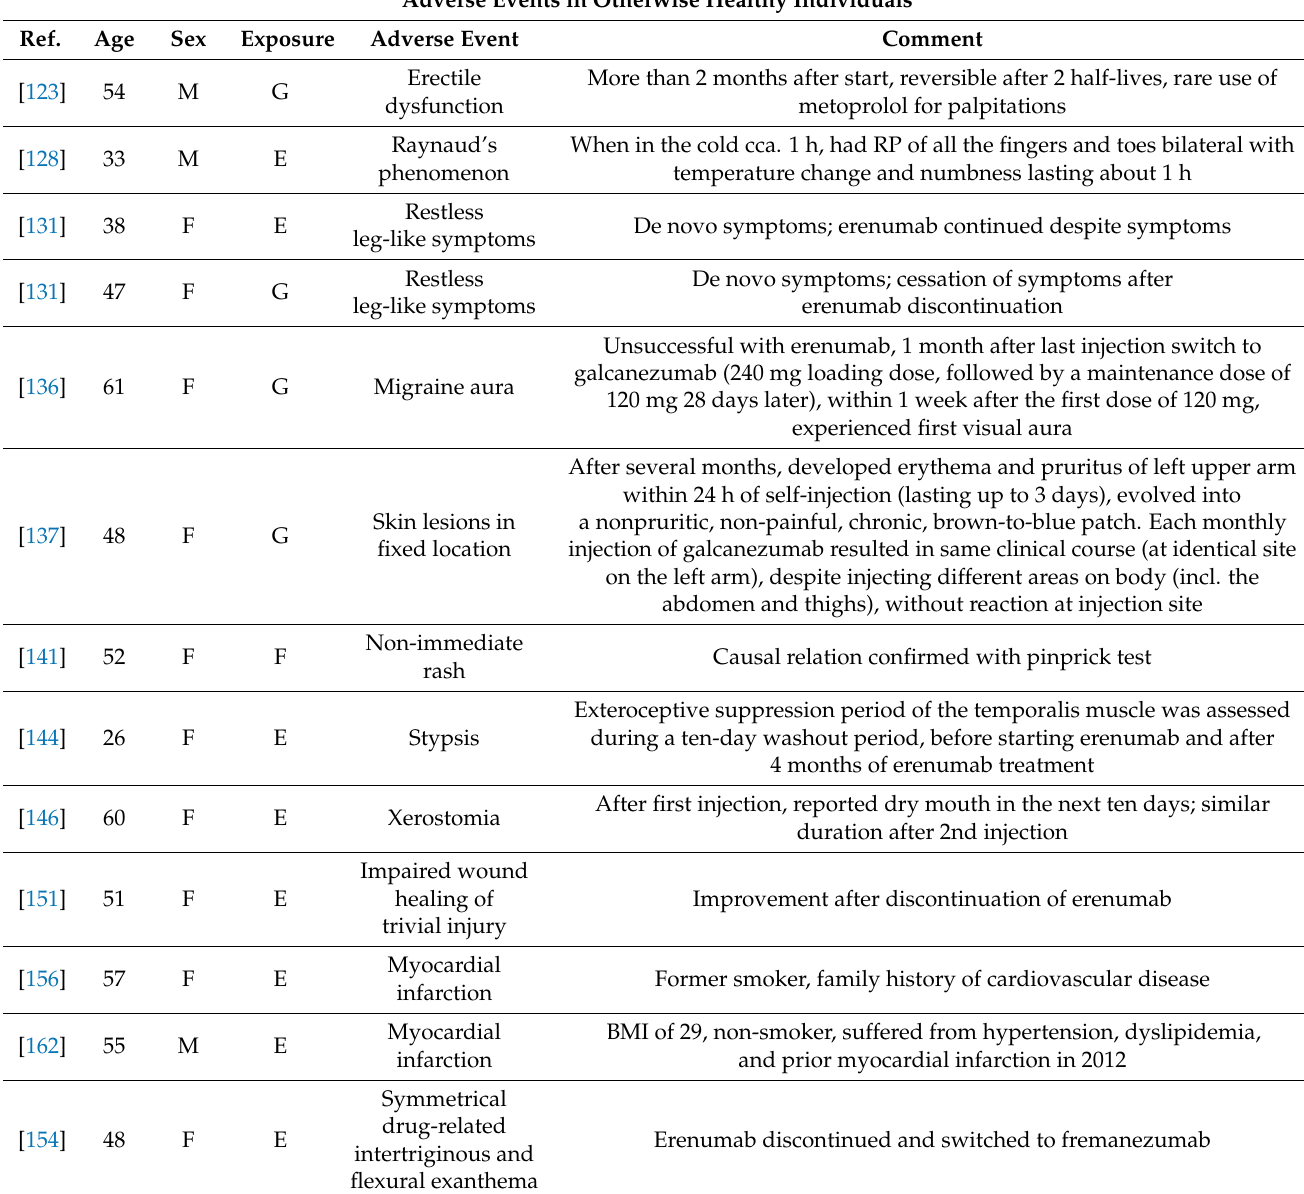
Table 3. Adverse events from case